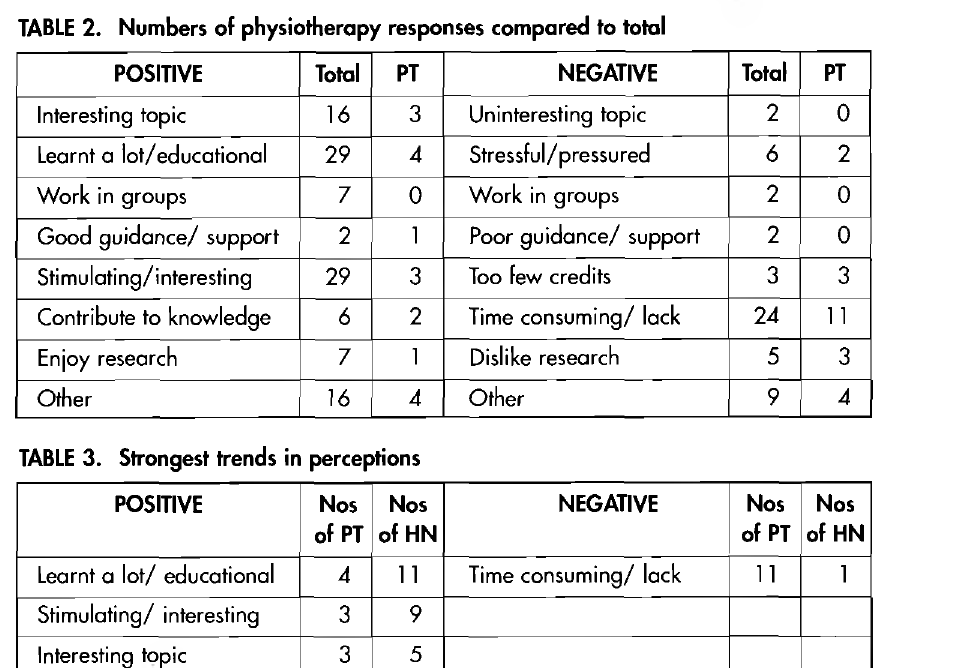
TABLE 2. Numbers of physiotherapy responses compared to total